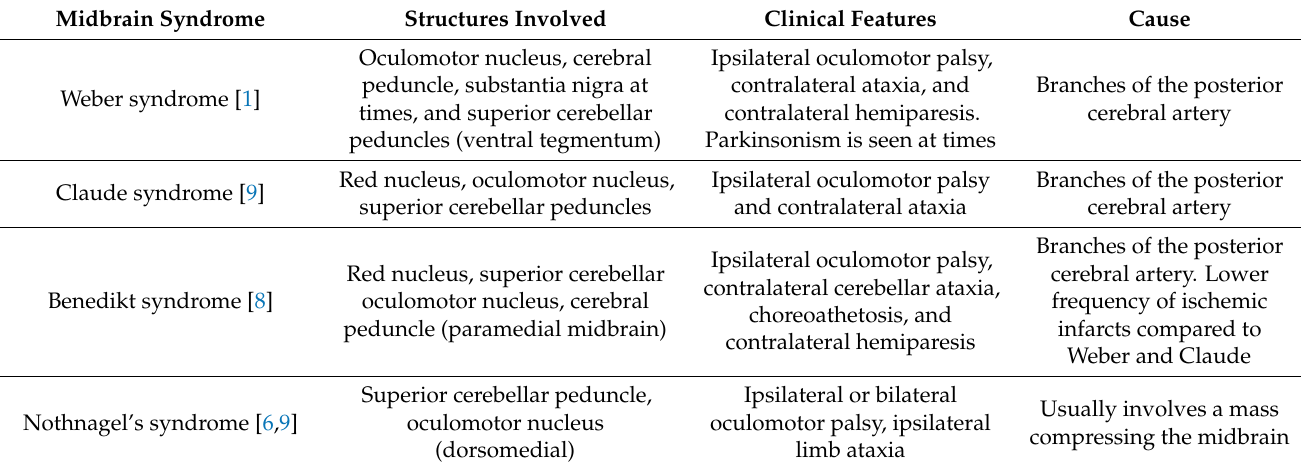
Table 2. Differential diagnosis of Parinaud’s syndrome.